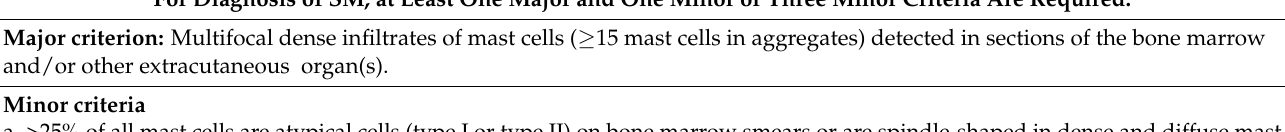
Table 2. 2022 WHO diagnostic criteria for systemic mastocytosis (SM)